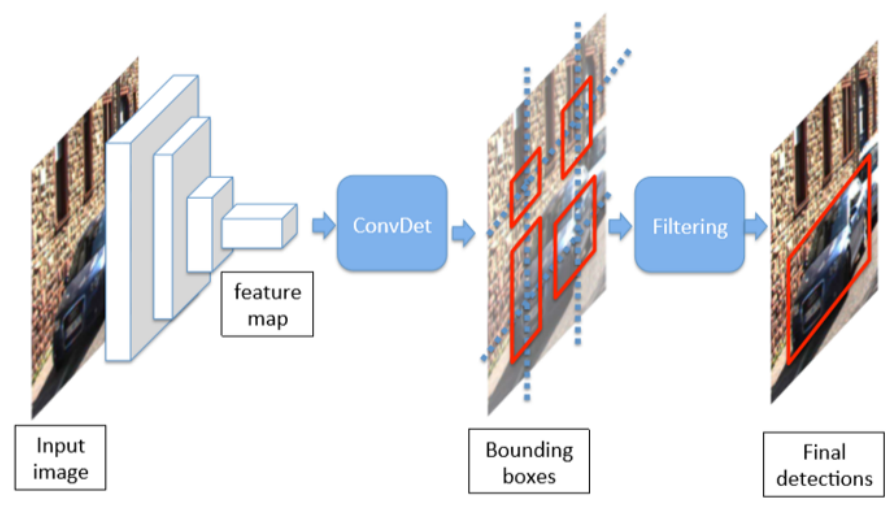
Figure 13. SqueezeDet architecture [45].